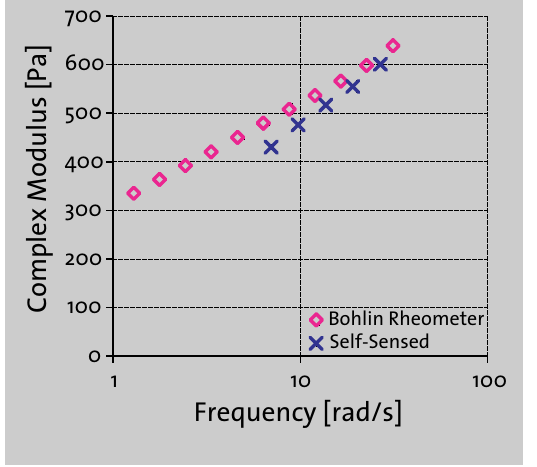
Figure 8 (left): Complex modulus of 5% polyethylene oxide solution. Figure 9 (right): Delta angle of 5% polyethylene oxide